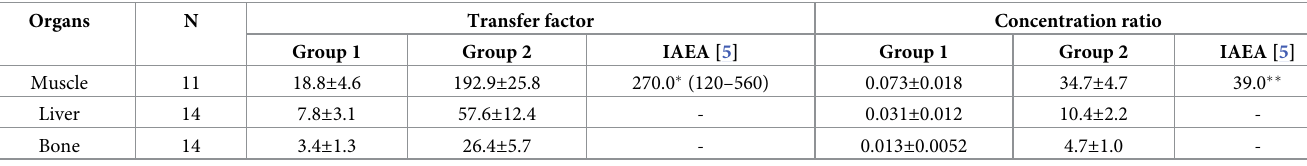
fed, not less than 20 days’; ��